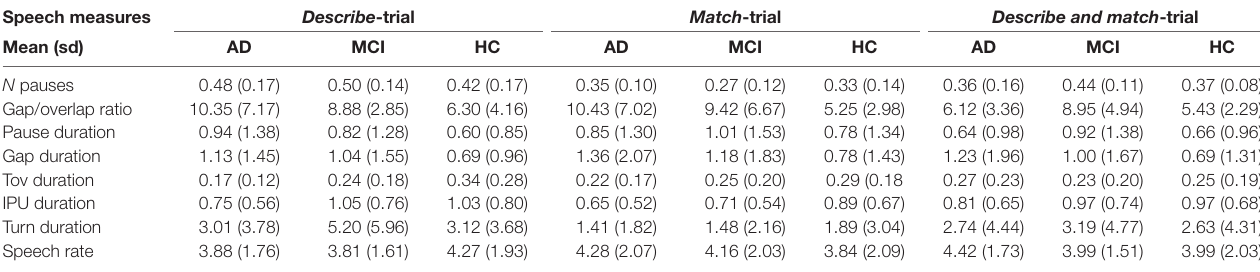
TABLE 2 | Mean and standard deviation of the speech characteristics per group and trial. Speech